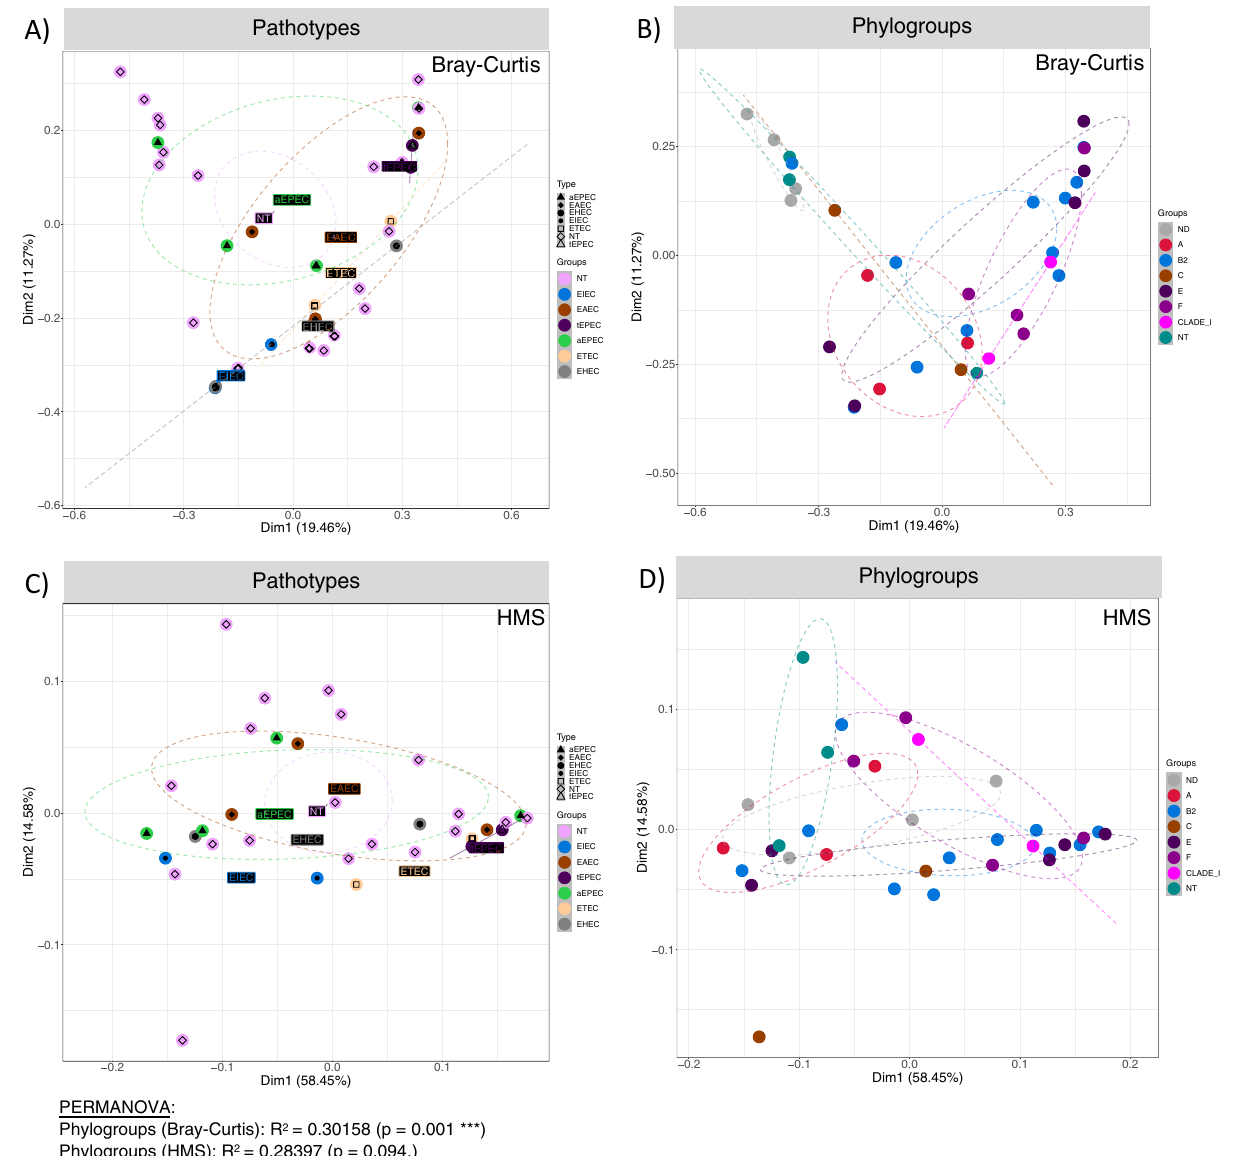
Figure 3. Principal coordinate analysis (PCoA) using different several dissimilarity indices [Bray–Curtis distance and hierarchical meta-storm (HMS)] where ellipses were drawn using 95% confidence intervals based on the standard error of ordination points for a given category. Beneath each figure are the R 2 values (along with p-values if significant) calculated from